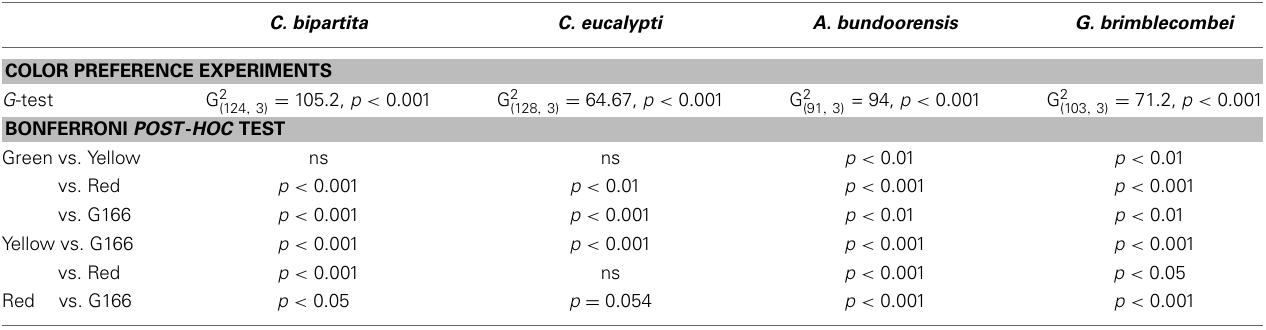
Table 2 | Summary of statistics for Experiment 2 (red vs. G45) and Experiment 3 (shades of gray).